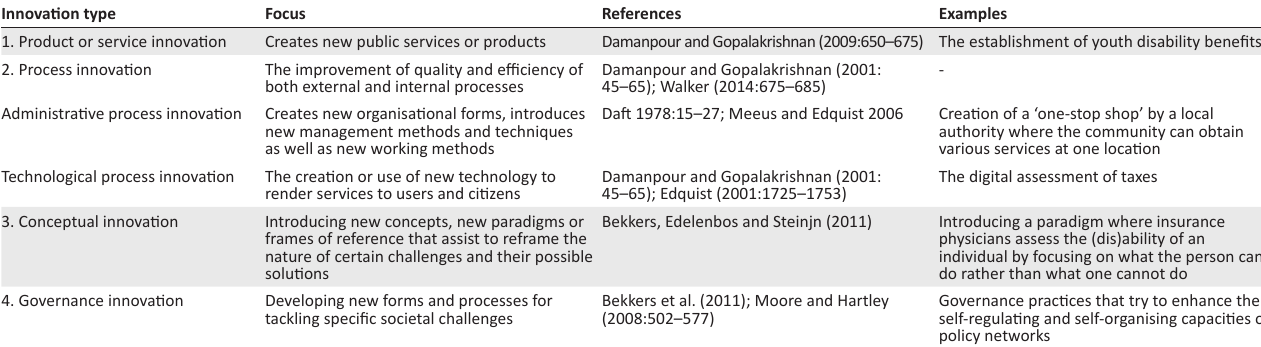
TABLE 1: Types of public-sector innovation. Innovation type